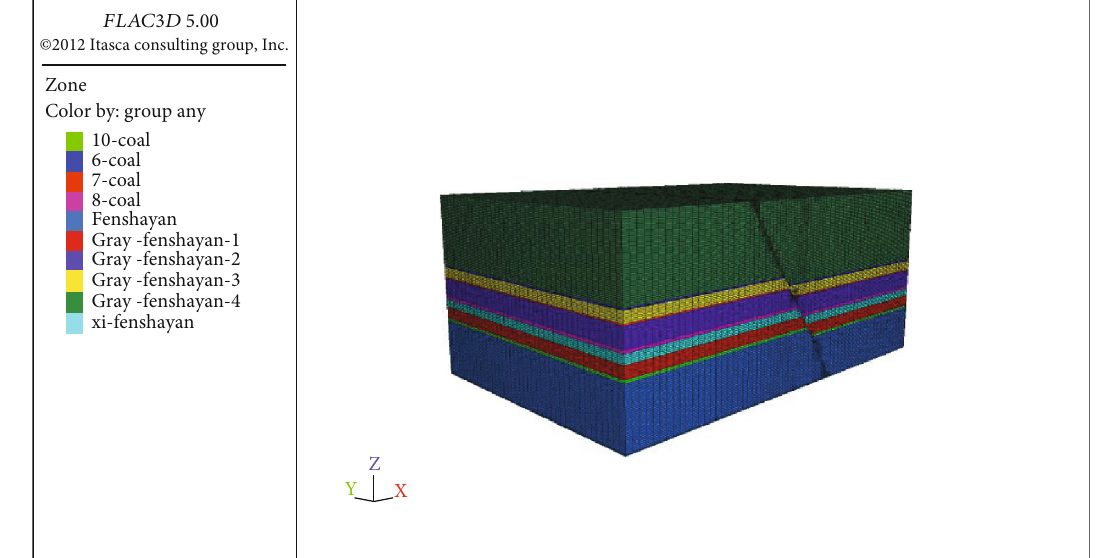
Figure 8: Stress distribution model and meshing of surrounding rock in coal seam